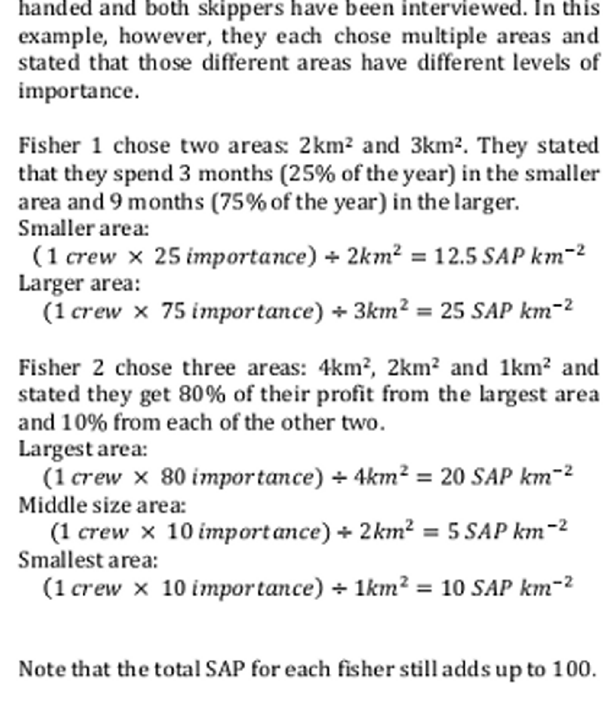
Figure 2. Illustrative example of basic SAPM. Illustrative example of basic SAPM, no weighting or scaling involved.